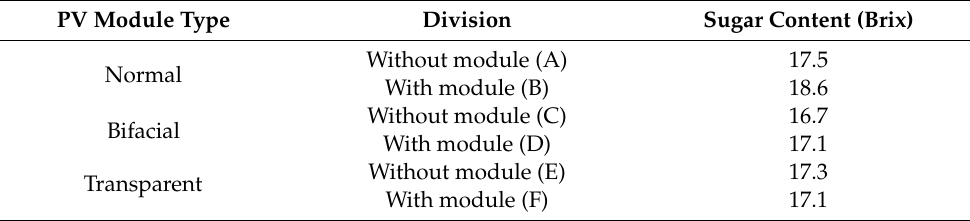
Table 3. Changes in sugar content according to PV module in ripe